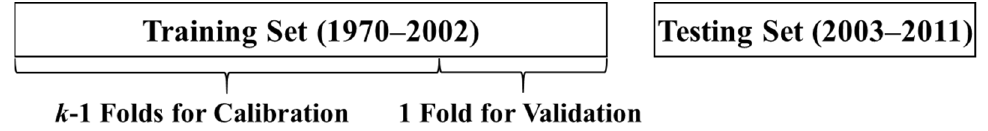
Figure 5. Training set and testing set division scheme.